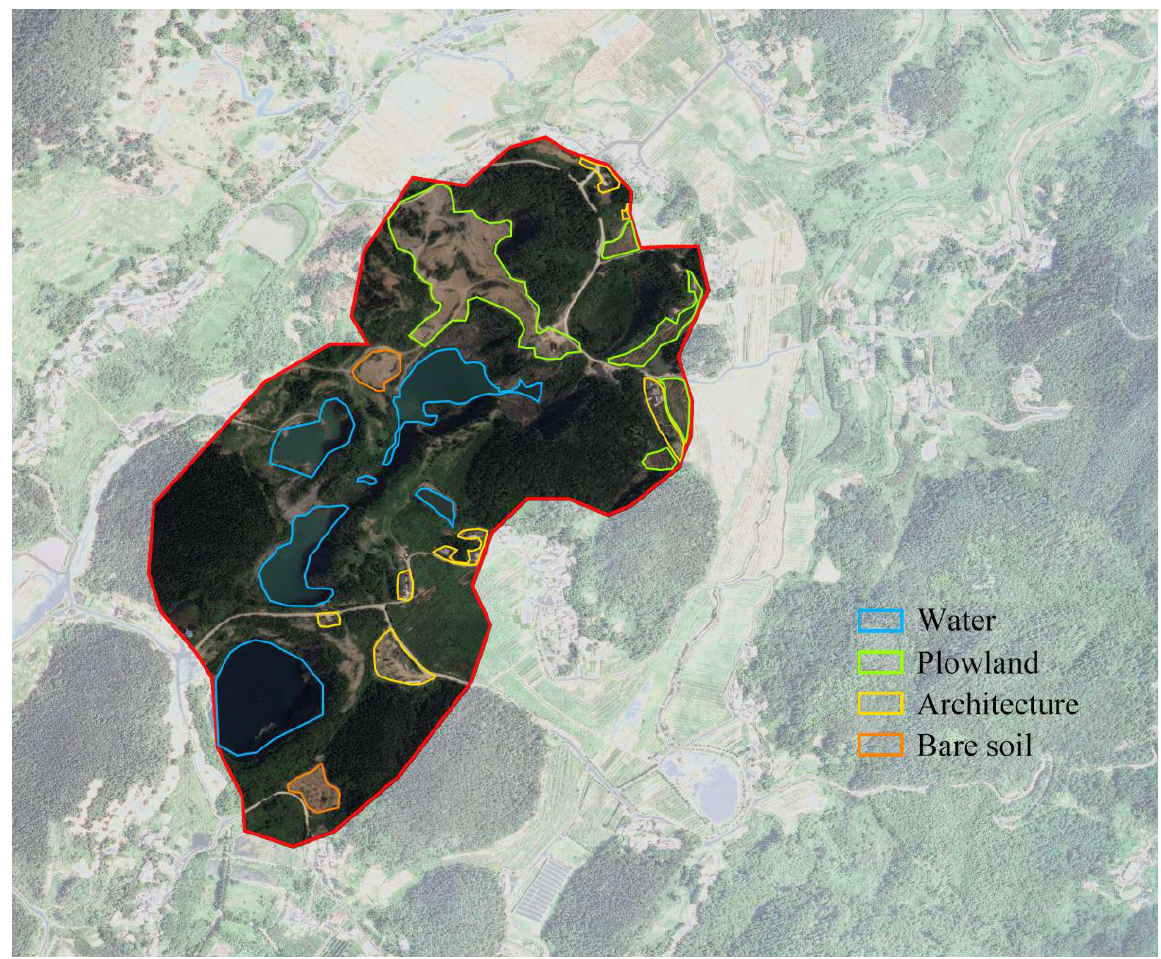
Figure 3. Aerial map with the sampling locations.